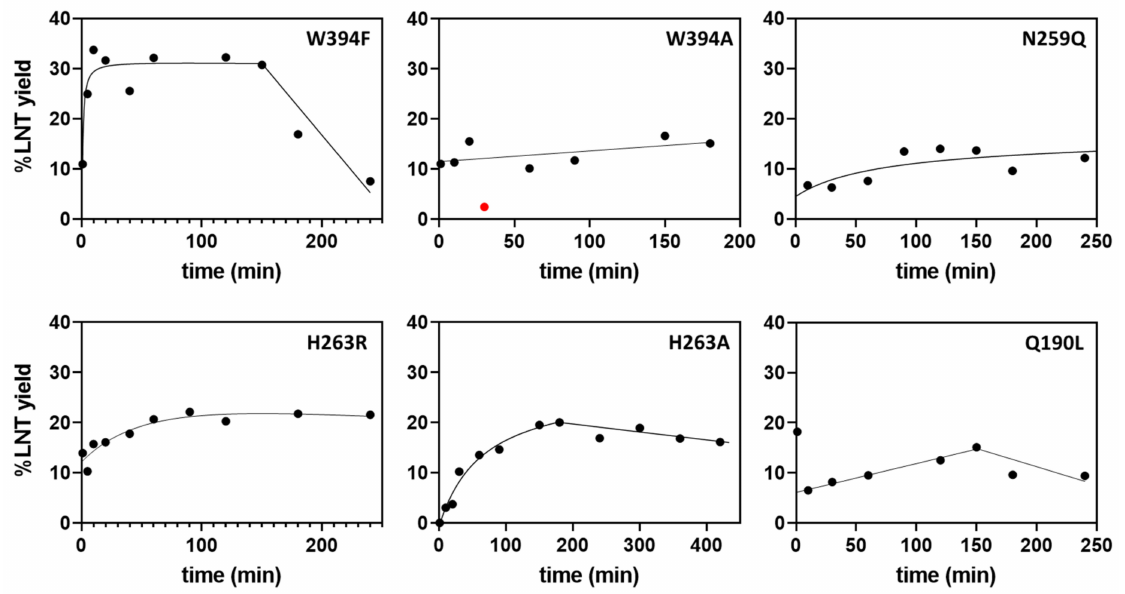
Figure 3. Time course monitoring of LNT formation by HPLC-MS for selected mutants (%LNT max